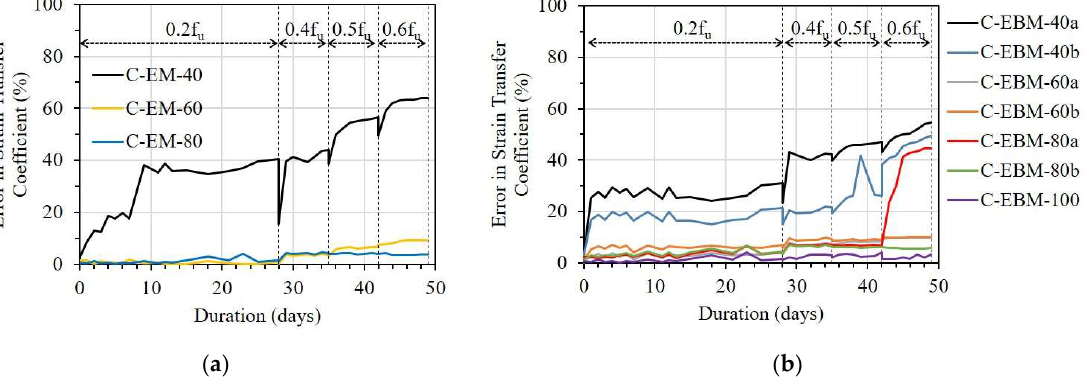
Figure 18. The error in strain transfer coefficient of the C specimen with different bond lengths: ( a ) Embedded method and ( b ) Externally bonded method.